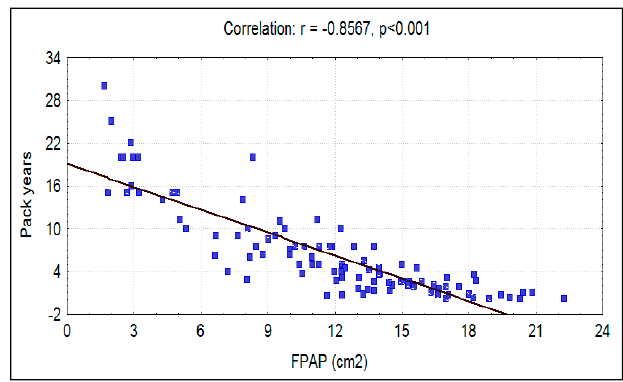
Figure 8. Correlation between pack-years with FPAP (per cm 2 ) in smokers.